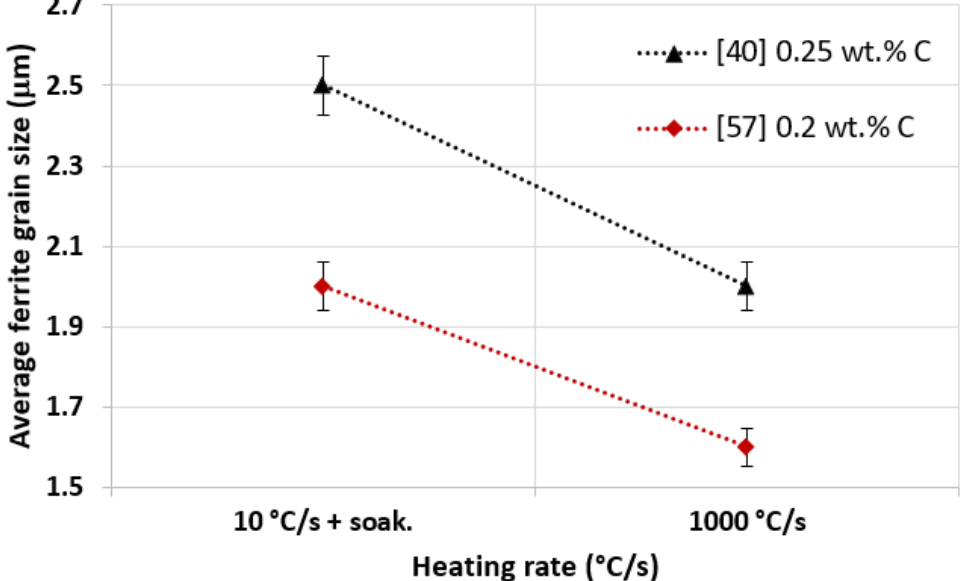
Figure 2. Effect of the heating rate increase on ferritic grain size. Low/medium carbon steel (0.25 wt. % C and 0.2 wt. % C), peak temperature of 850 °C and 950 °C, cooling rate of 20 °C/s and 160 °C/s (data from [40,57]).